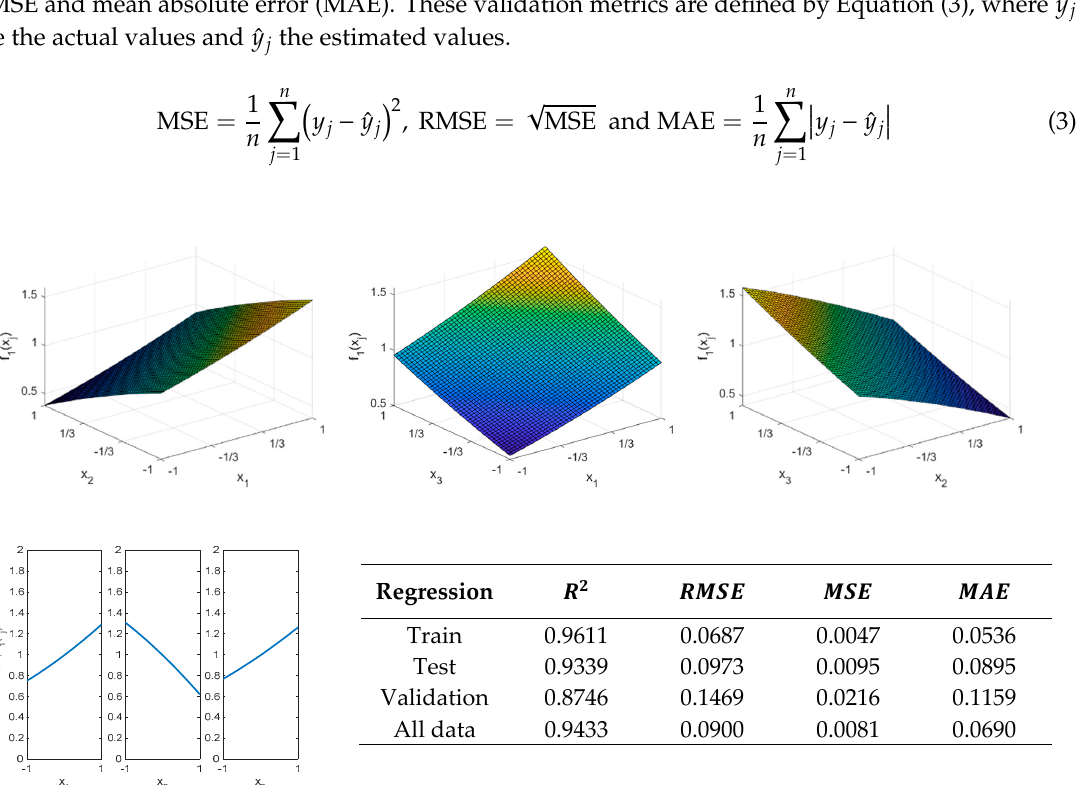
Figure 4. Response surfaces obtained, main effects plot and results of the validation metrics obtained with the RSM model for the case of type 1 function ( f 1 ).